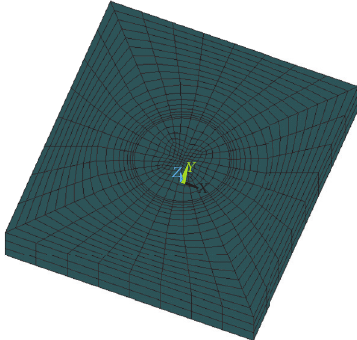
Figure 4: The model of uniaxial penetration creep test finite